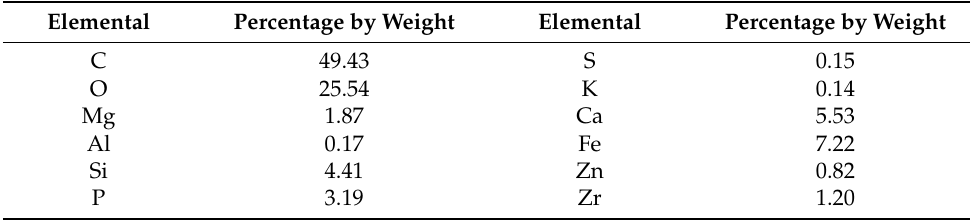
Figure 7. EDS quantitative elemental analysis of GDI PM. Table 3. The elemental content of gasoline particulates.